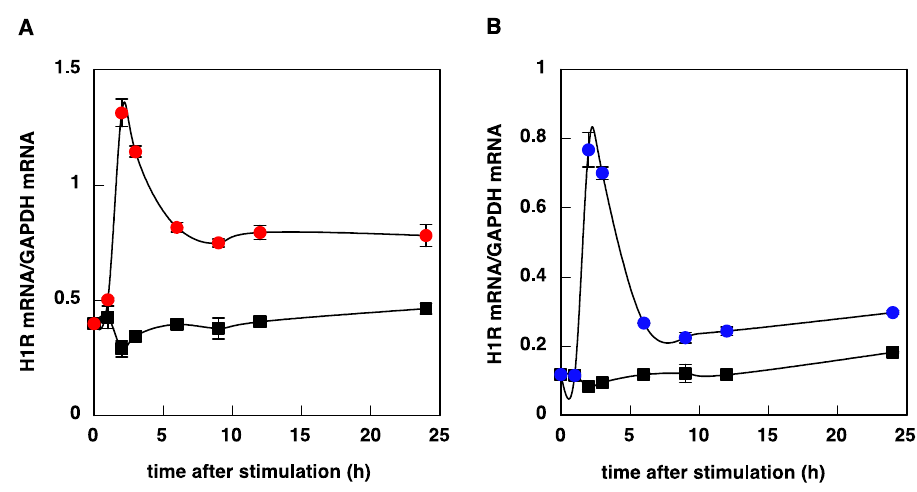
Figure 7. Time course of histamine-induced upregulation of H1R mRNA derived from B/K splice variant in U-373 MG cells ( A ) and HeLa cells ( B ). At given time intervals after stimulation with 100 μ M (U-373 MG cells) or 10 μ M (HeLa cells) histamine, total RNA was isolated, and B/K splice variant mRNA was determined by real-time quantitative RT-PCR using B/K specific primer and probe shown in Materials and Methods. Closed circles, B/K splice variant; closed squares, control. Data are expressed as means ± SEM ( n = 6–9).